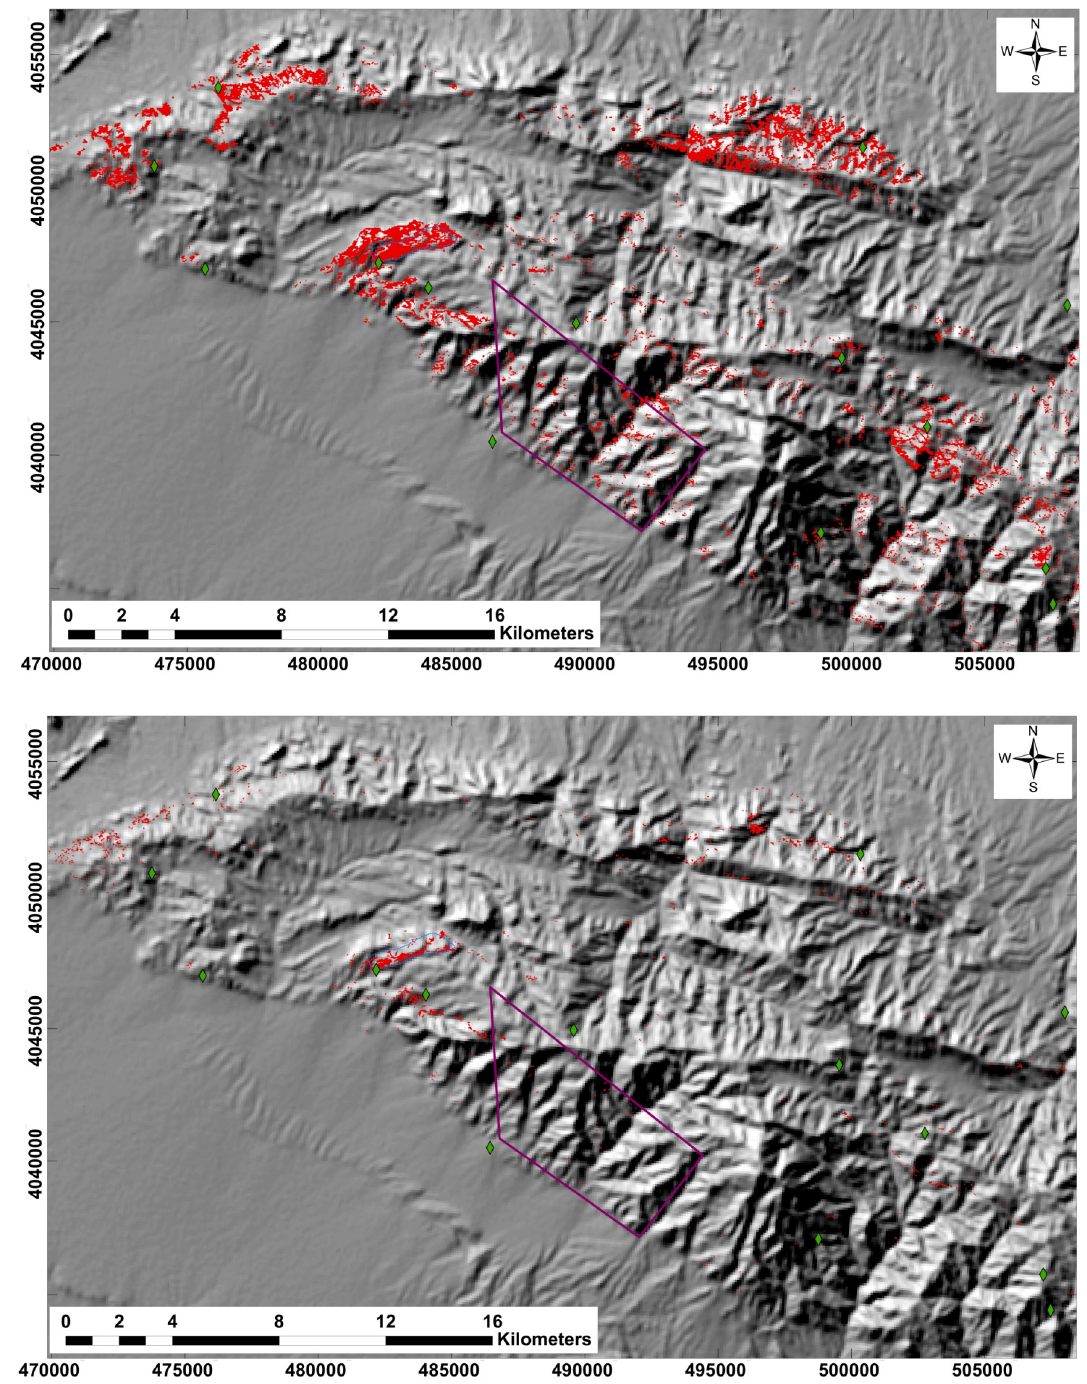
Figure 7. The upper image (red pixels) is the result of overlapping SAM from Aster, and CEM from TM with reference spectra extracted from the pit of the chromite mine. The lower image is the SAM results using extreme values (lowest maximum angle) to show highly probable chromite minerali- zation